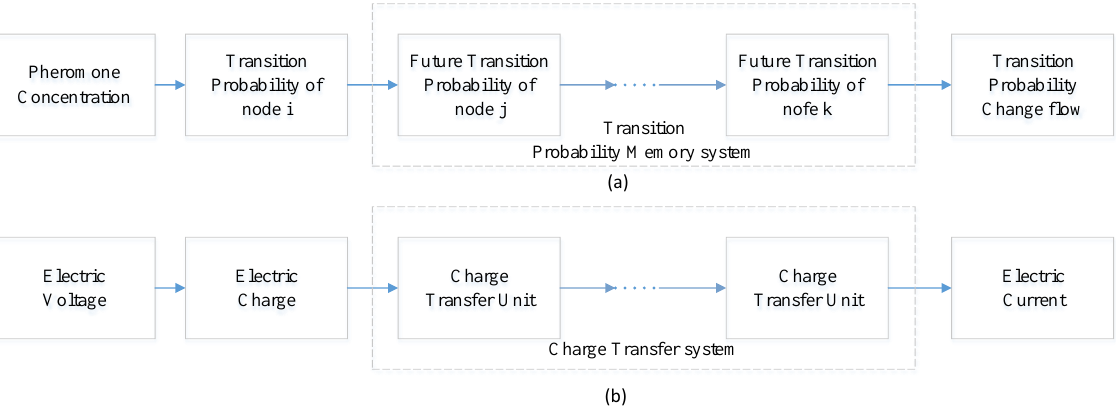
Figure 4. The analogy of FACA and fracmemristor: ( a ) transition probability sequence in FACA; and ( b ) charge transfer in fracmemristor.